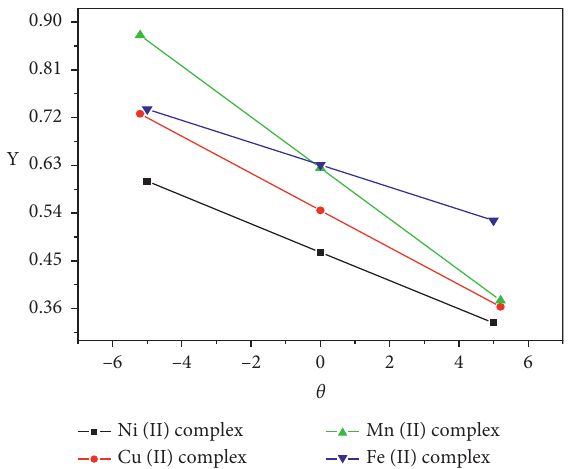
Figure 7: Horowitz–Metzger plot for complex 2 nd step in dynamic air.